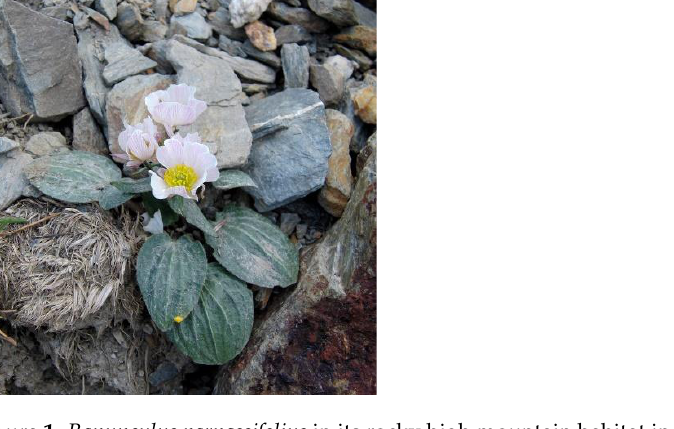
Figure 1. Ranunculus parnassifolius in its rocky high mountain habitat in the Catalan Pyrenees (image photo: Albert Mallol Camprubí).